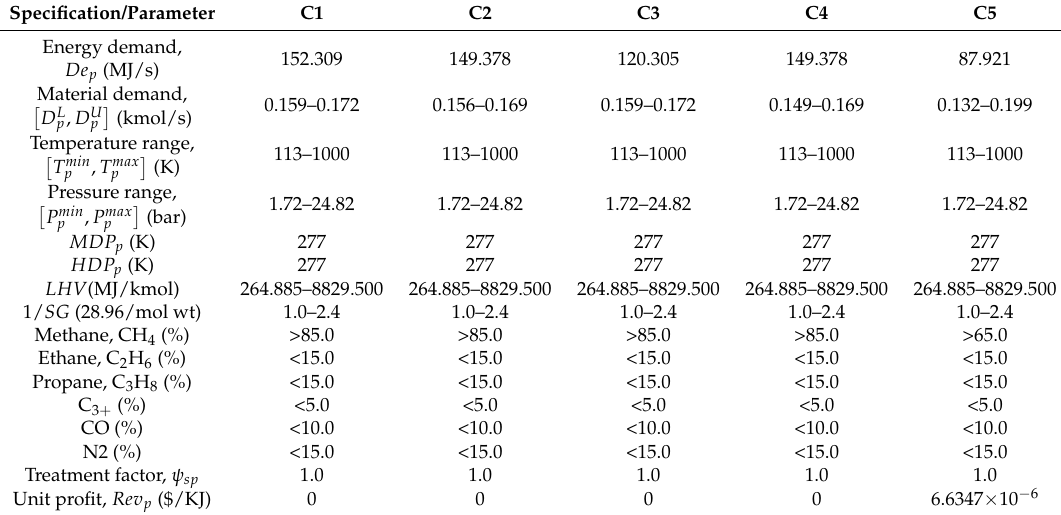
Table 3. Specification for product streams (sinks).